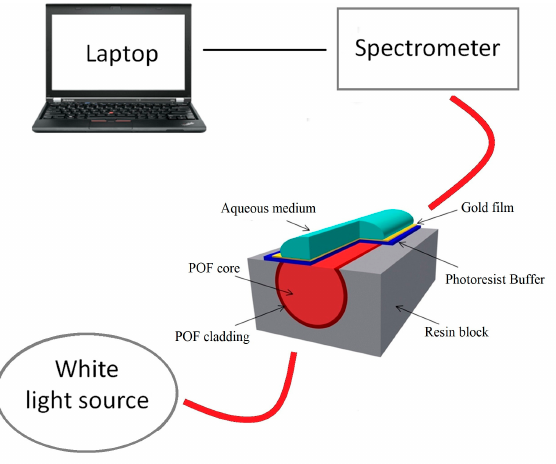
Figure 6. Schematic of the SPR-POF biosensor developed for the detection of naphthalene in water. Reproduced from [49].